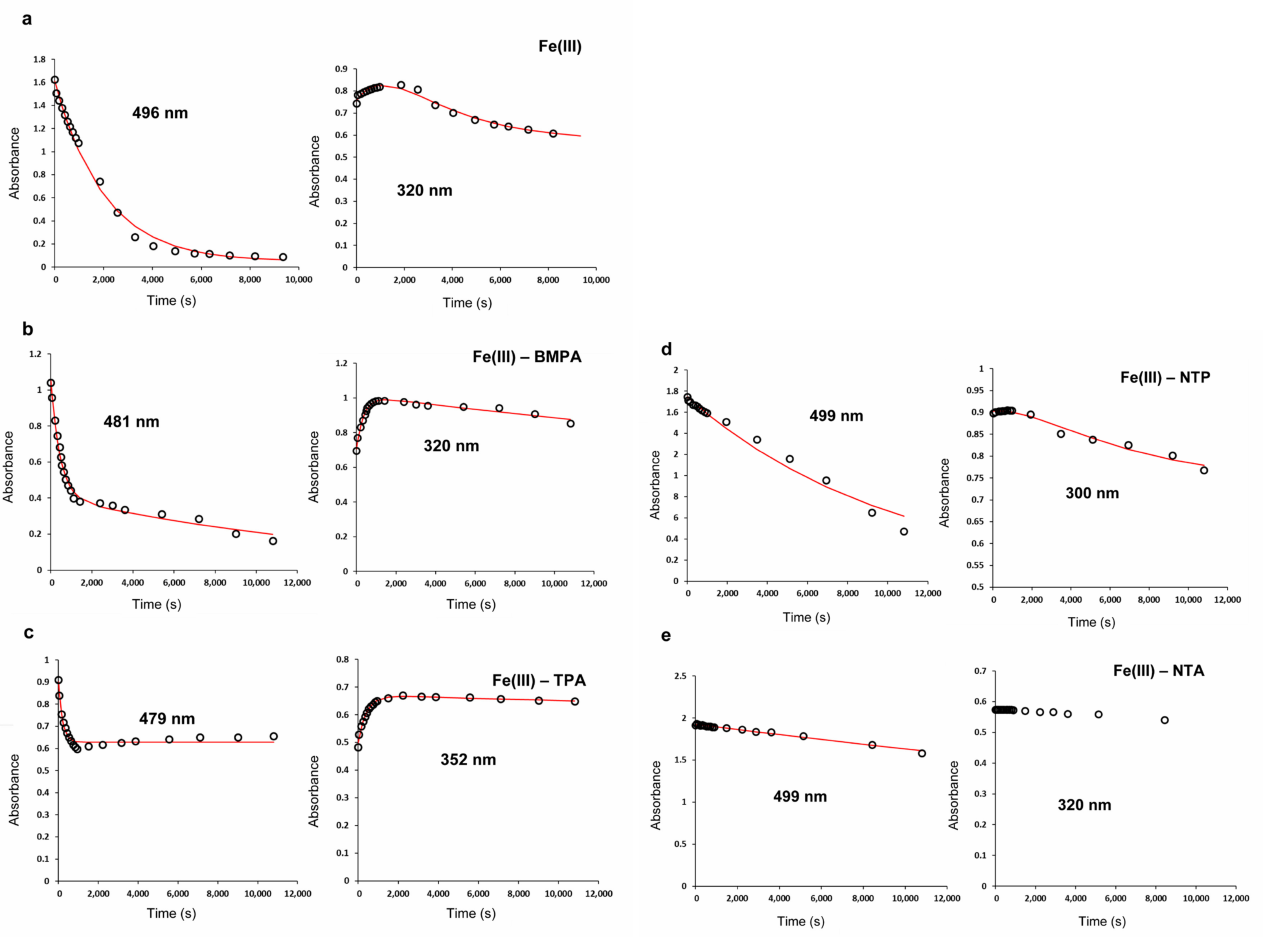
Figure 4. Time evolution of the absorbance for the MO degradation catalyzed by Fe(III) ( a ), Fe(III)-BMPA ( b ), Fe(III)-TPA ( c ), Fe(III)-NTP ( d ) and Fe(III)-NTA ( e ). The specific wavelength of measurement is also indicated. The optimal kinetic model is represented in each case as a red line. Conditions: T = 20.0 ◦ C; 3 h; [MO] = 6 × 10 − 5 mol L − 1 , [Fe] = [ligand] = 1.9 × 10 − 4 mol L − 1 , [H 2 O 2 ] = 2.93 × 10 − 3 mol L − 1